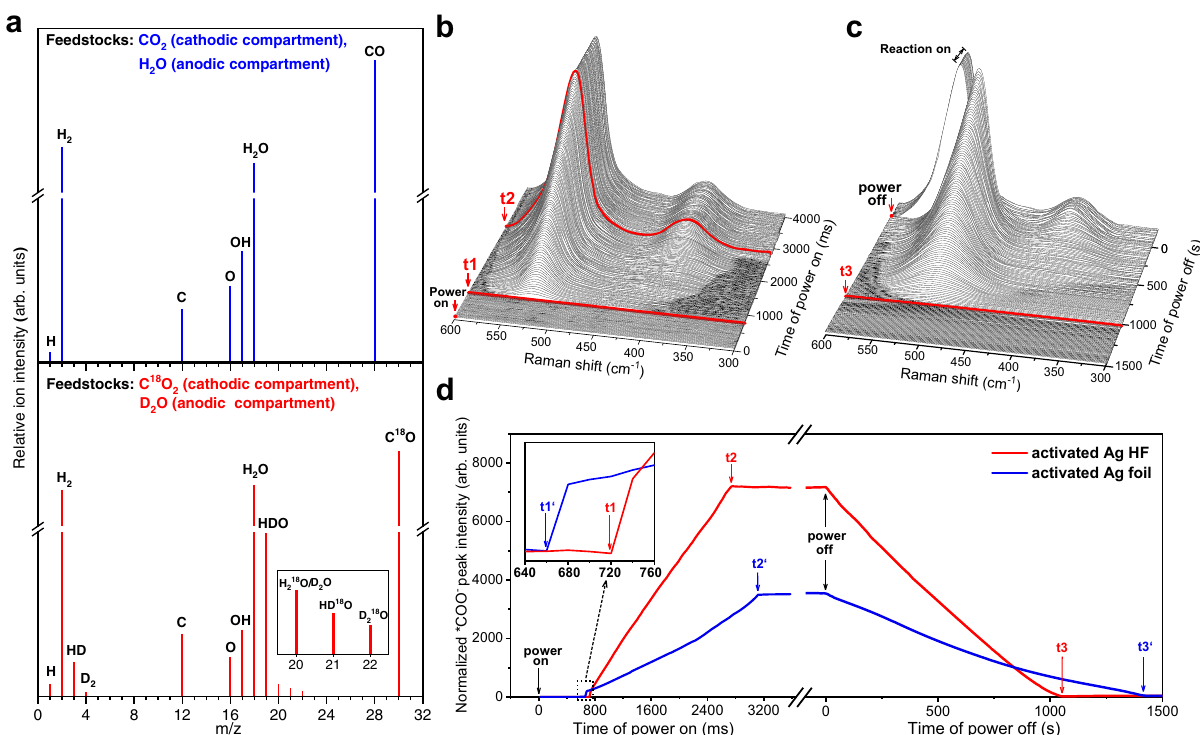
Fig. 6 Isotopic trace and time-resolved operando Raman results. a Mass spectrometric detections of the cathodic products over activated Ag HF using unlabeled feedstocks (upper) and isotopically labeled C 18 O 2 and D 2 O feedstocks (lower), respectively. b , c Time-resolved operando Raman spectra showing the formation, evolution and dissipation of intermediates over activated Ag HF. d Comparison of the normalized *COO − peak intensities of activated Ag HF and activated Ag foil during the power-on and power-off